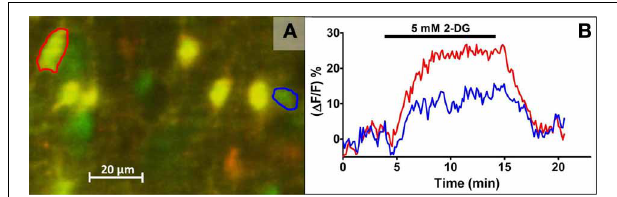
FIGURE 1 | Live cell calcium imaging of NST astrocytes in response to glucoprivic challenge. In vivo co-injection of the calcium indicator dye, Calcium Green 1-AM (CAG; green) and the glial vital stain sulforhodamine 101 (SR101; red) allows for simple discrimination of astrocytes and neurons in the in situ brain stem slice preparation. Following a dual exposure utilizing the 488nm and 561nm laser lines, a composite image is obtained in which astrocytes are clearly labeled yellow, i.e., positive for both CAG and SR101, while neurons remain green (A) . Time-lapse imaging with only the 488nm laser line can then be used to follow changes in intracellular calcium concentrations, indicated by a proportional change in the intensity of the CAG signal, before, during, and after the application of glucoprivic or low glucose challenges. Regions of interest (ROI) were drawn around an individual neuron (blue circle) and astrocyte (red circle) in (A) for analysis of their time-lapse responses to 2-DG challenge (B) . Exposure time to 2-DG is represented by bar over